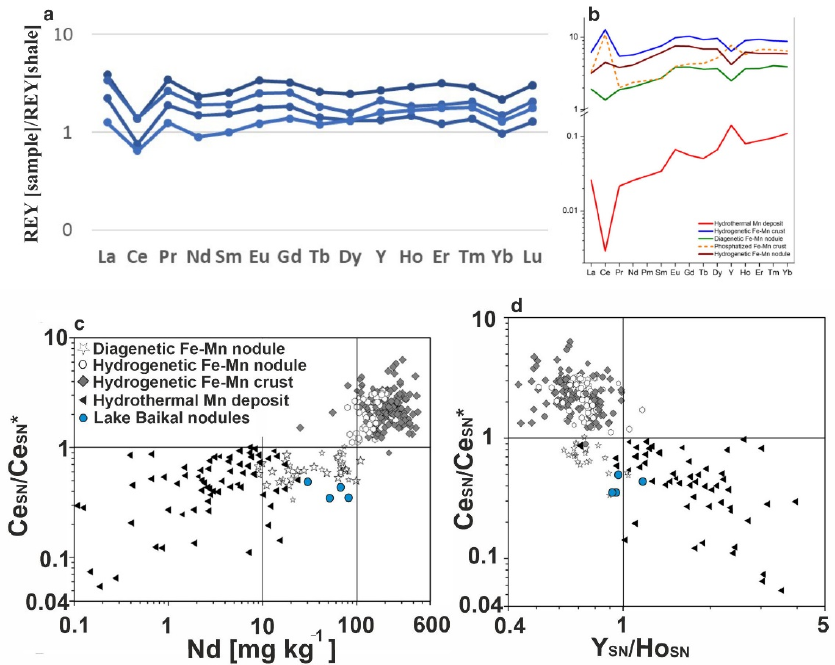
Figure 11. ( a ) Distribution of REY normalized to PAAS of Fe-Mn nodules from Ushkani islands; ( b ) Examples of typical REY patterns of marine hydrothermal Fe and Mn deposits, diagenetic Fe–Mn nodules, hydrogenetic Fe–Mn nodules, hydrogenetic Fe–Mn crusts, and phosphatized hydrogenetic Fe–Mn crusts; Marine Fe–Mn oxyhydroxide deposits for ( c ) Ce SN /Ce SN * vs. Nd concentration and ( d ) Ce SN /Ce SN * ratio vs. Y SN /Ho SN (Bau et al., 2014); SN is shale normalized to Post-Archean Australian Shale, PAAS (McLennan, 1989); Ce* = Ce anomaly (Ce SN * = 0.5La SN + 0.5 Pr SN ). According to Colman et al. [100] and Vologina et al. [101], the age of the sediments studied is about 10,000–12,000 years, which is younger than the Fe-Mn nodules. The DNA from microorganisms, which are involved in diagenetic processes, and those from sedi- ments presumably precipitate for a long time on the surface or inside the Fe-Mn nodules and have been preserved until now. Therefore, it is most likely that the bacterial diversity of Fe-Mn nodules reflects the communities of the area studied for a period of 100 Ka. The hypothesis presented here will have to be tested through a more thorough sampling of Fe-Mn nodules from different depths of sediments, as well as through studies of isotopic composition and composition of microbial communities in nodules from different depths. Our results show that the composition of microbial communities of Fe-Mn sedimen- tary layers differed from those of surface sediments and Fe-Mn nodules. Bacterial and archaeal groups associated with the oxidation of nitrogen and methane compounds mainly dominated the communities of Fe-Mn layers. Chemolithoautotrophs that are as- sociated with ammonia-oxidizing archaea and nitrite-oxidizing bacteria can potentially play an important role as primary producers of Fe-Mn substrates in freshwater Lake Baikal, which is similar in marine ecotopes. However, the above results are not final be- cause the diversity of microbial communities from Fe-Mn deposits also clearly demon- strates an individual variability in different areas of Lake Baikal as well as in the World Ocean [9,21,49,105]. Nevertheless, the data obtained expanded our knowledge about the diversity and structure of microbial communities as well as their potential role as possible participants of dissolution/formation of the buried Fe-Mn oxide layer in the deep-water Lake Baikal.